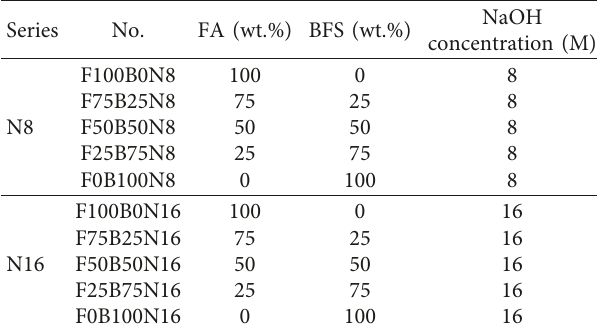
Table 2: The summary of the experimental